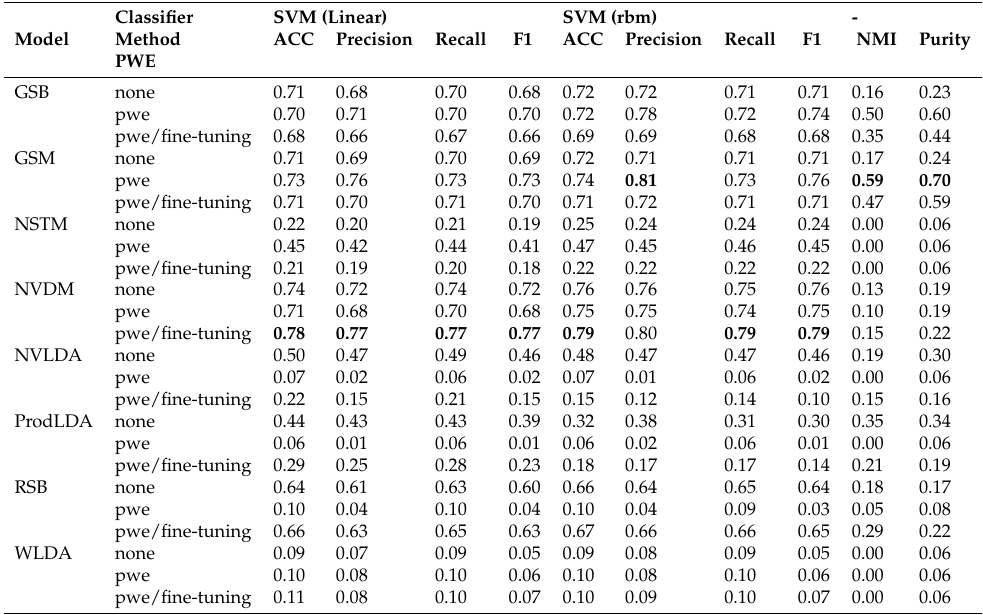
Table 31. Classification and Clustering performance on